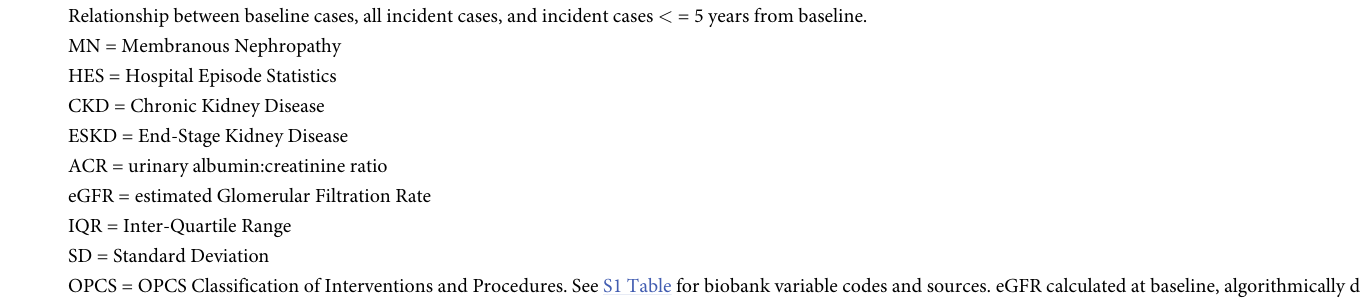
OPCS = OPCS Classification of Interventions and Procedures. See S1 Table for biobank variable codes and sources. eGFR calculated at baseline, algorithmically derived ESKD assessed throughout follow up